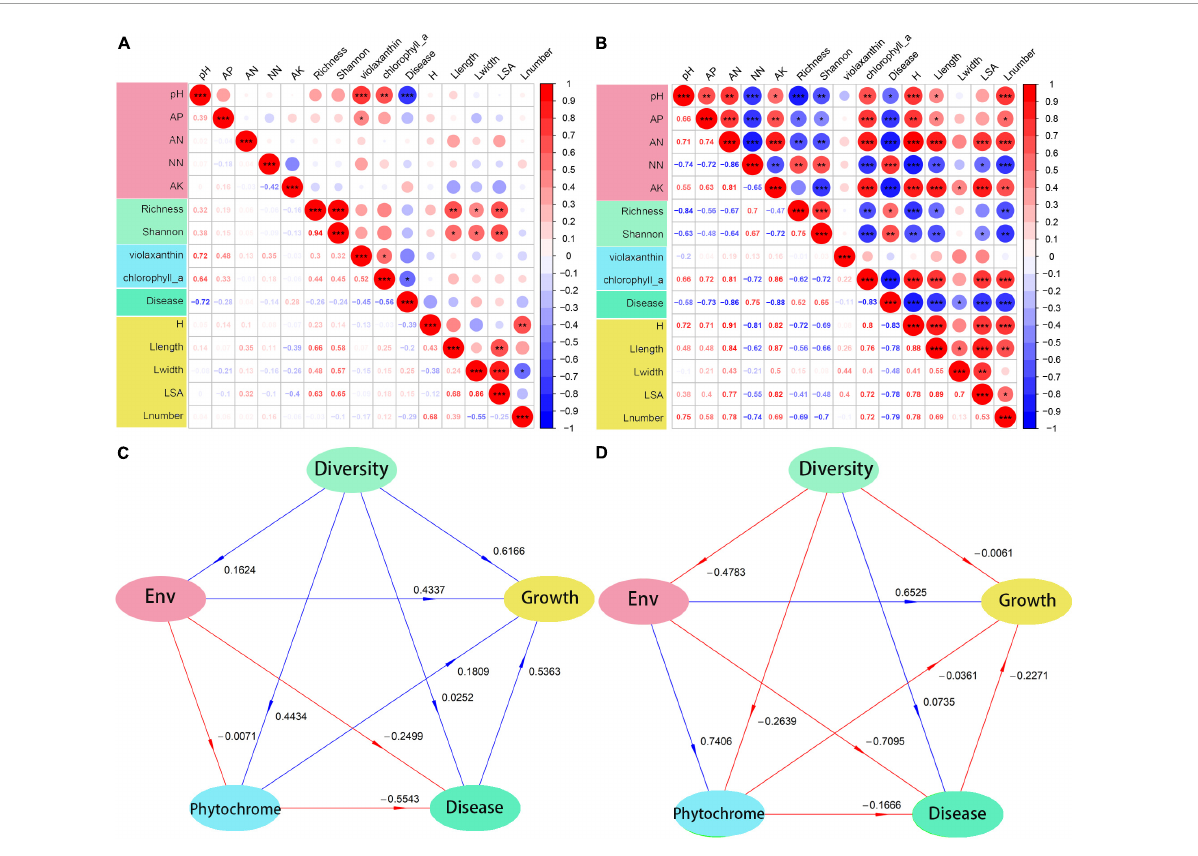
FIGURE6 Correlation relationship and PLSPM model of soil physiochemical properties, microbial diversity, phytochrome contents, disease infection and plant growth. (A,C) Biological treatment and (B,D) fumigation treatment. ENV, soil physiochemical properties. *0.01 ≤ p < 0.05; **0.001 ≤ p < 0.01; *** p <